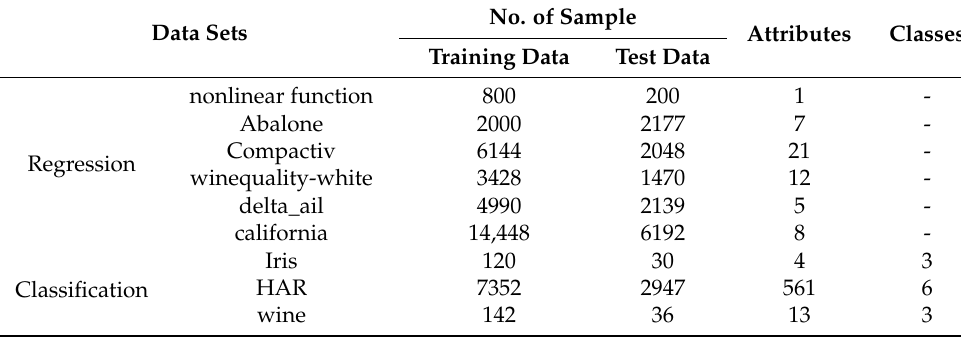
Table 1. Specifications of data